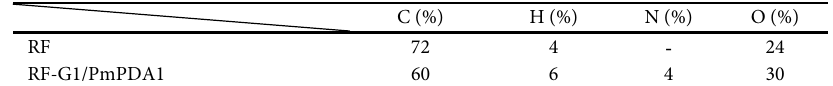
Table 2. The weight percentage of the present elements on the surface of RF and RF-G1/PmPDA1 aerogels